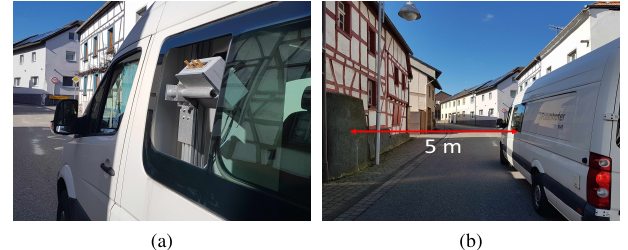
Figure 5. Carborne SAR experiments. (a) Antennas and front-end behind the open window. (b) Sensor platform and measuring